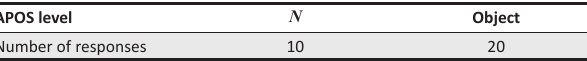
TABLE 9: Frequency of students’ responses for task 1c (iii) according to APOS